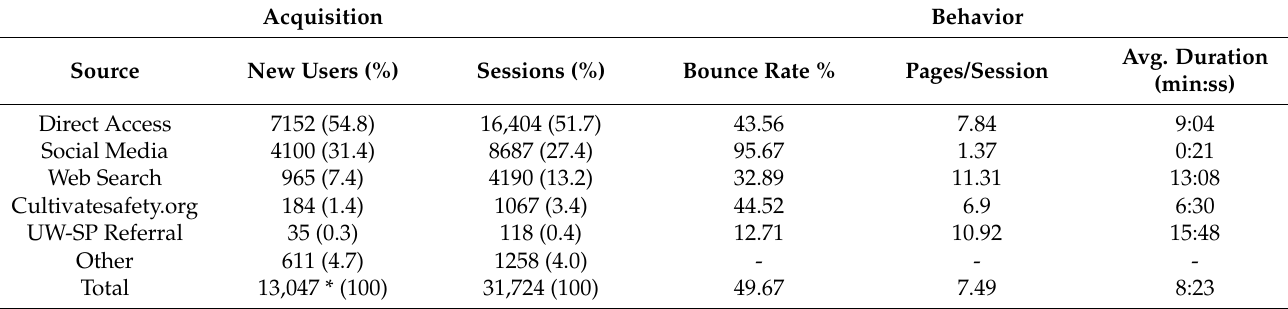
Table 3. User acquisition sources and behavior during site sessions.